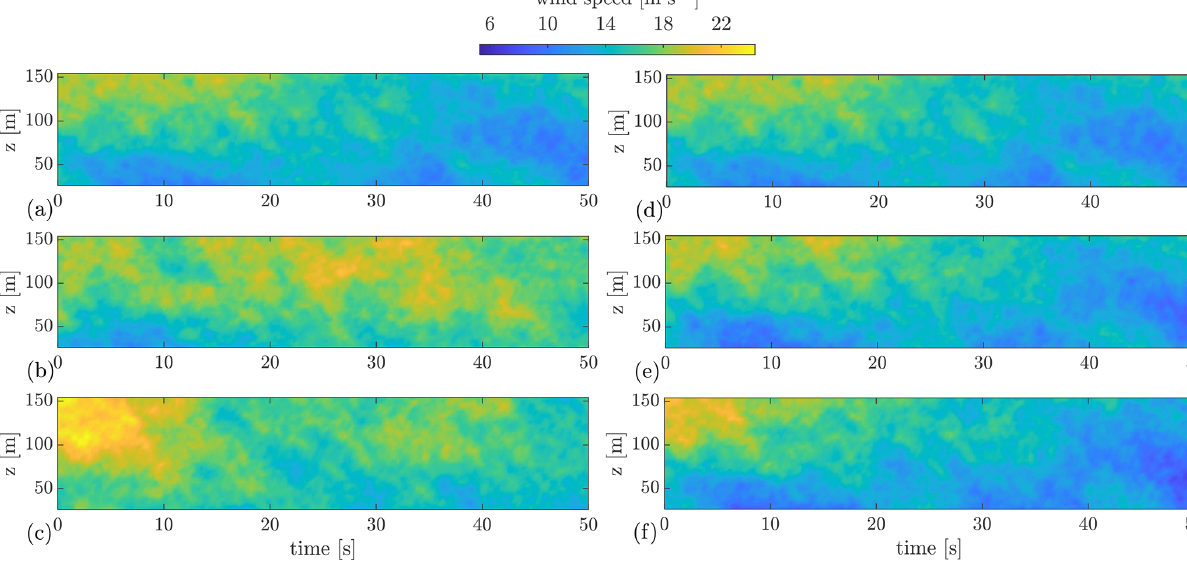
Figure 4. Illustration of the U component in a 4D wind field. Panels (a) – (c) are three independent realizations of 3D turbulent wind fields generated with the Mann turbulence generator, which are fed into evoTurb. Panels (d) – (f) are the corresponding vertical planes at x = 0m, x = 50m, and x = 100m in the 4D wind field. The temporal shifts due to the longitudinal separations are not shown.